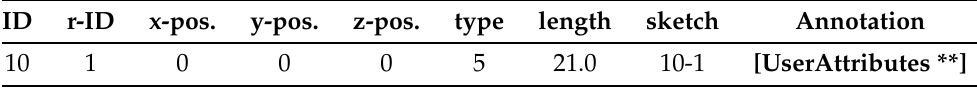
Table A6. Extrusion Feature used as target for the Annotations of Appendix C Tables A1–A5.